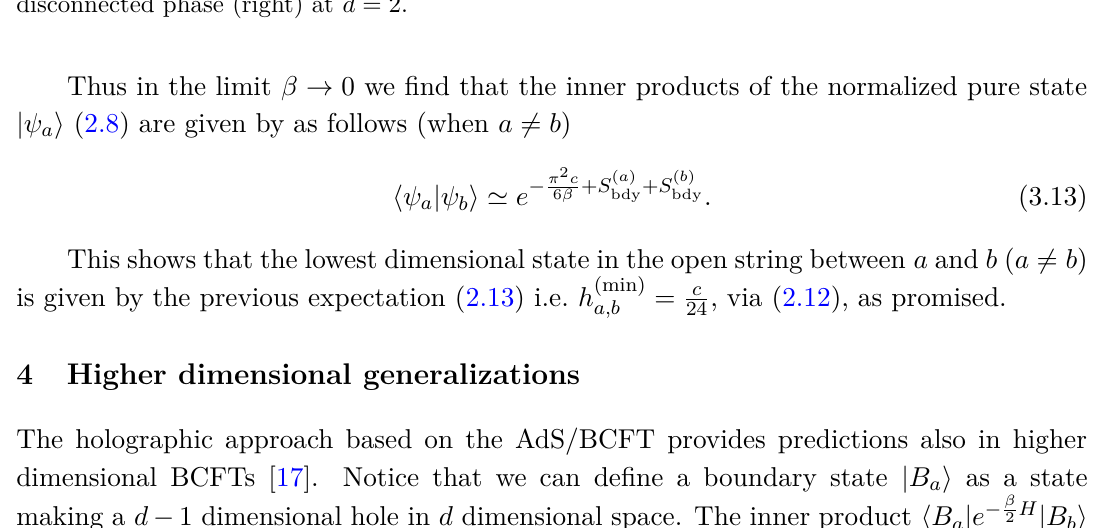
Figure 2 . A sketch of gravity duals of a CFT on a cylinder in the connected phase (left) and disconnected phase (right) at d = 2